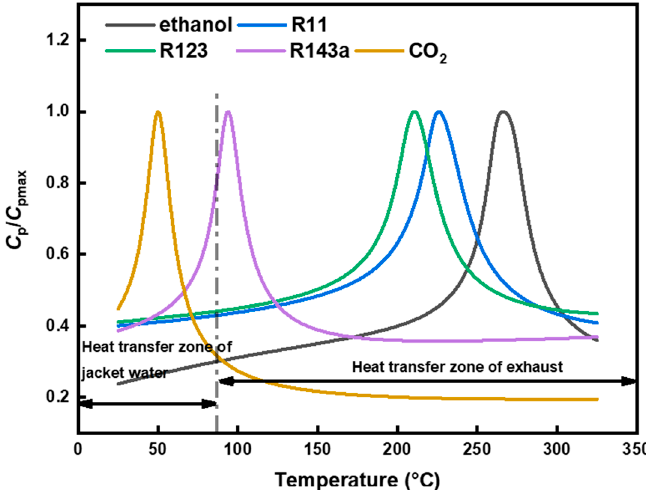
Figure 3. Variation of c p / c p,max with temperatures for different fluids under critical pressure.